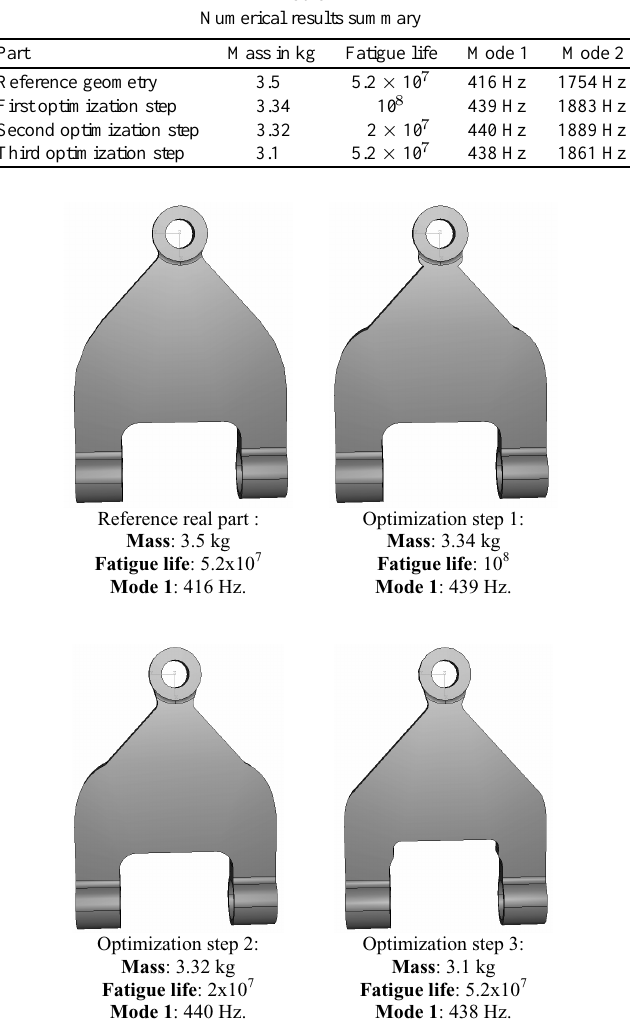
Fig. 11. Optimization process: shape changes in the automobile